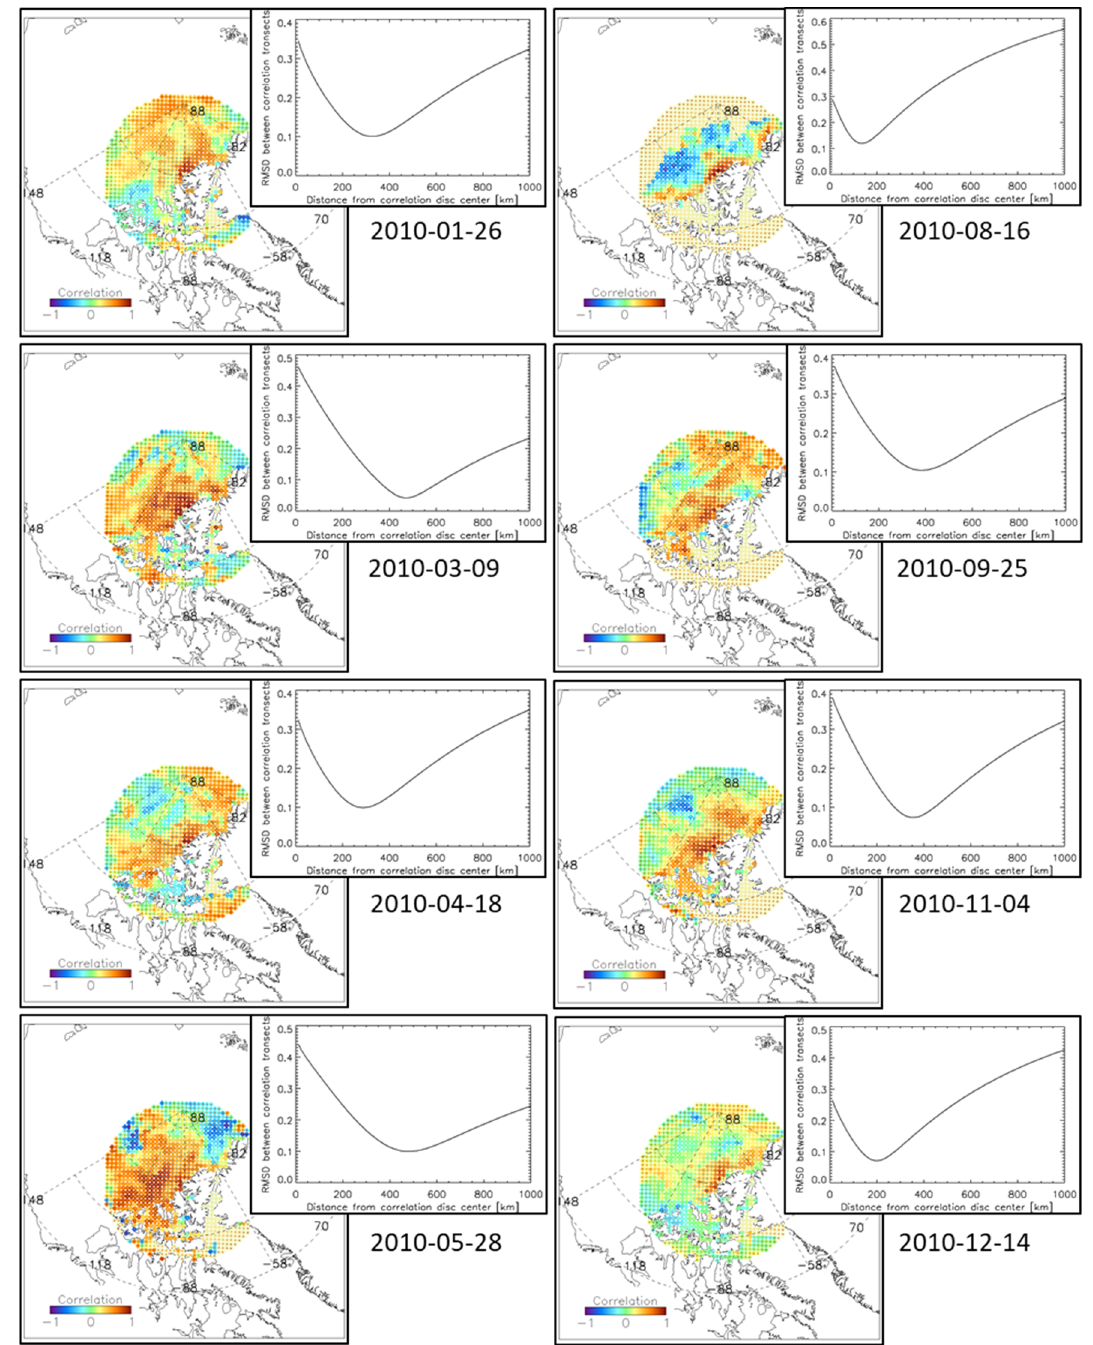
Figure 5. Illustration of the coverage with correlation discs and the associated RMSD profile derived for the set of exponential functions (see Figure 3) for the SIC error derived from SICCI-50km for the year 2010 for a sample region north of the Canadian Arctic Archipelago in the Northern Hemisphere. Panels are shown every 40 days. Only the map of 7 July is missing because of too few SIC values > 90%.